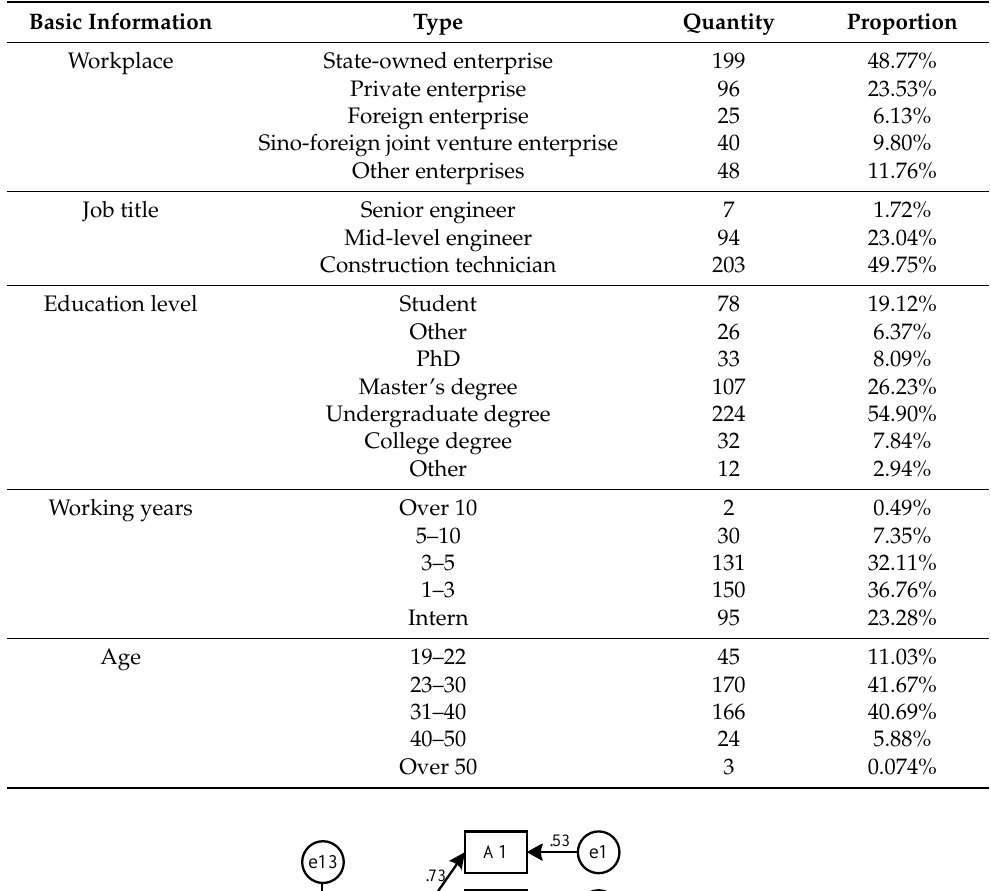
Table 1. Questionnaire sample data statistics.